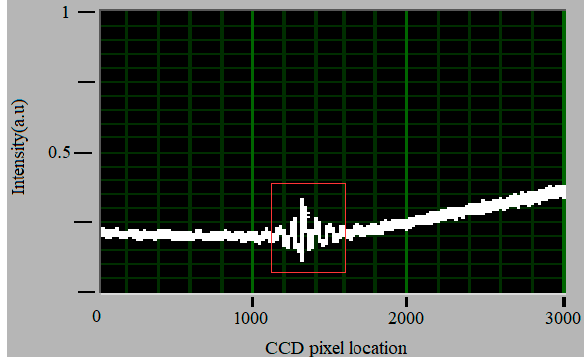
Figure 8. Interference patterns captured by the CCD of pressure demodulation device.